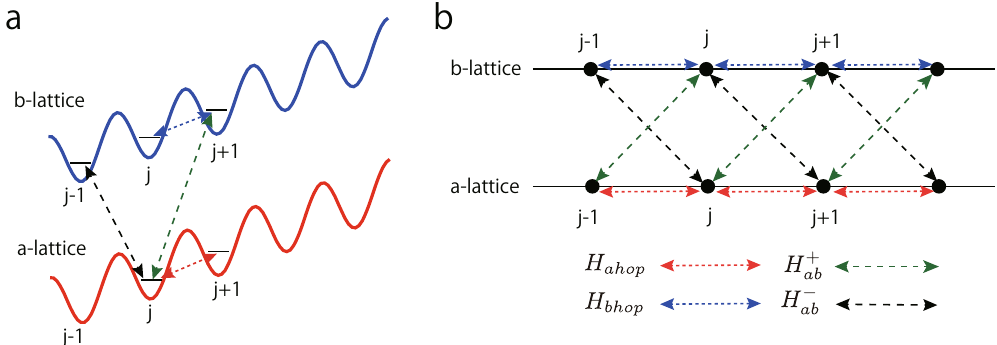
Figure 1. ( a ) Two parallel optical lattice. Each lattice traps a different internal state of fermion. The two lattices have the same tilt. ( b ) Four types of hopping term. In the exchange hopping term denoted by the black and green dashed arrows, the fermionic atoms hop to a different site in a different optical lattice with changing the internal